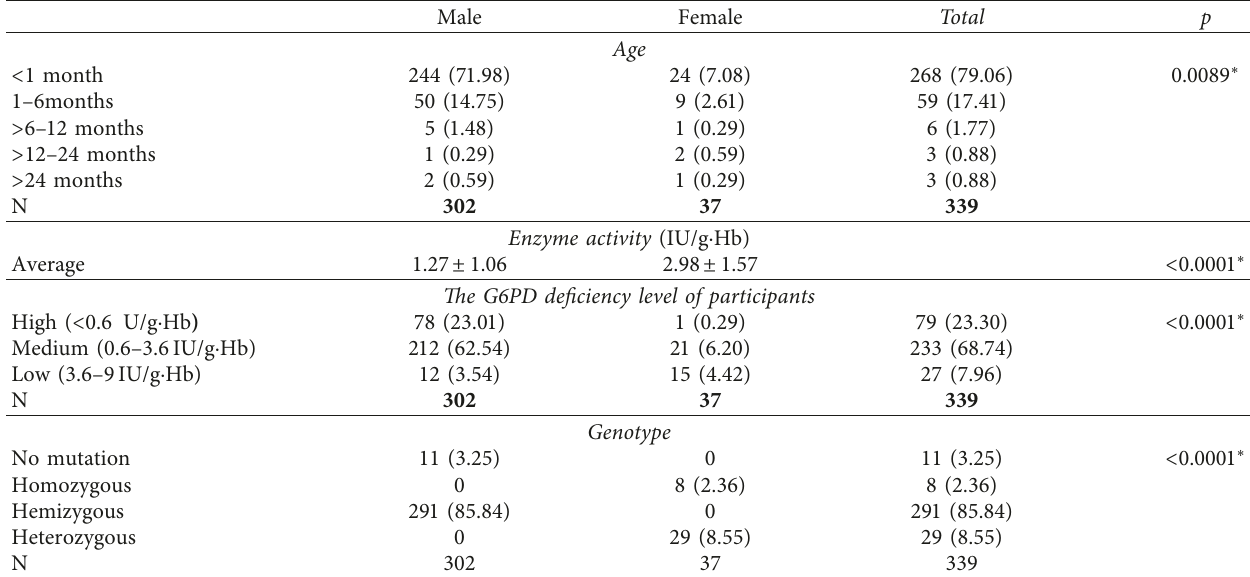
Table 1: Participant characteristics in this